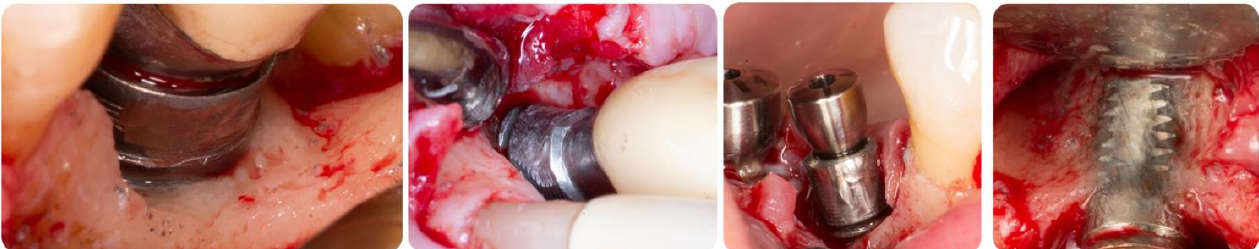
Figure 8. Intra-surgical view of peri-implant surfaces decontamination by means of implantoplasty. It is noticeable how difficult it is to completely remove titanium debris from the tissues, how it is not possible to completely reach the implant surface in narrow defects, and how much implant structure may have to be removed to accomplish smoothness. Narrower implants may risk fracture due to structural modification.